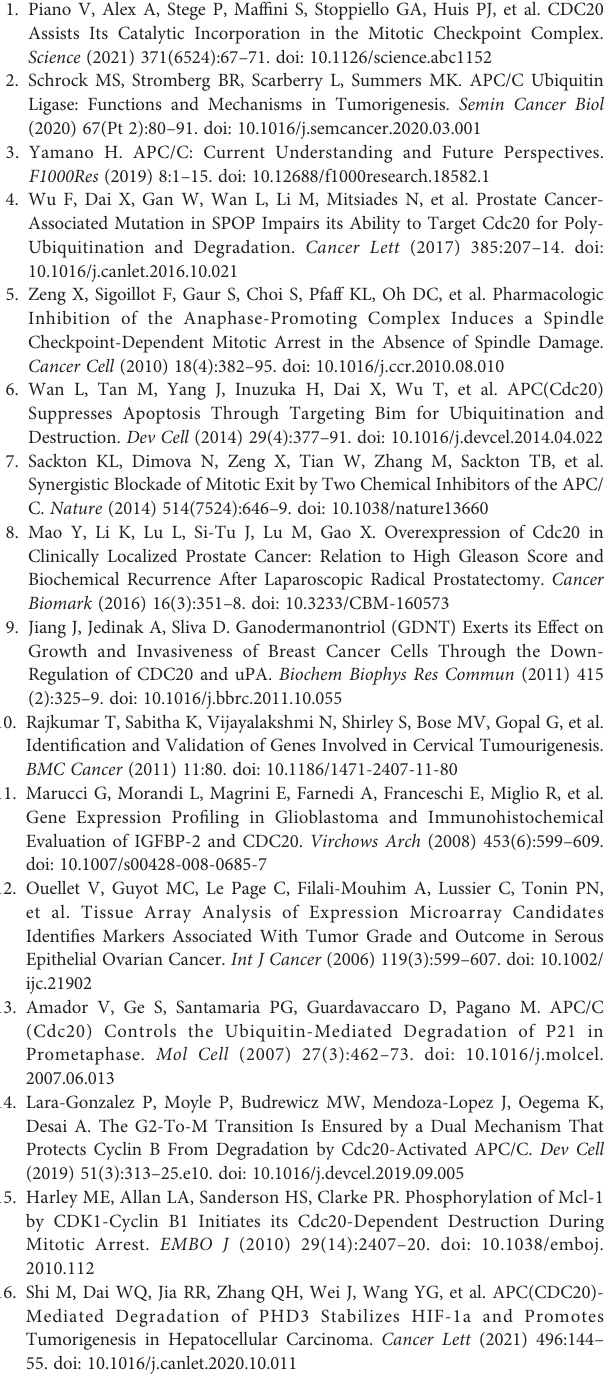
Supplementary Figure 3 | The mRNA expression of CDC20 gene in different types of tumors and matched normal tissues. The expression difference of CDC20 between tumors and matched control tissues were signi fi cantly increased in